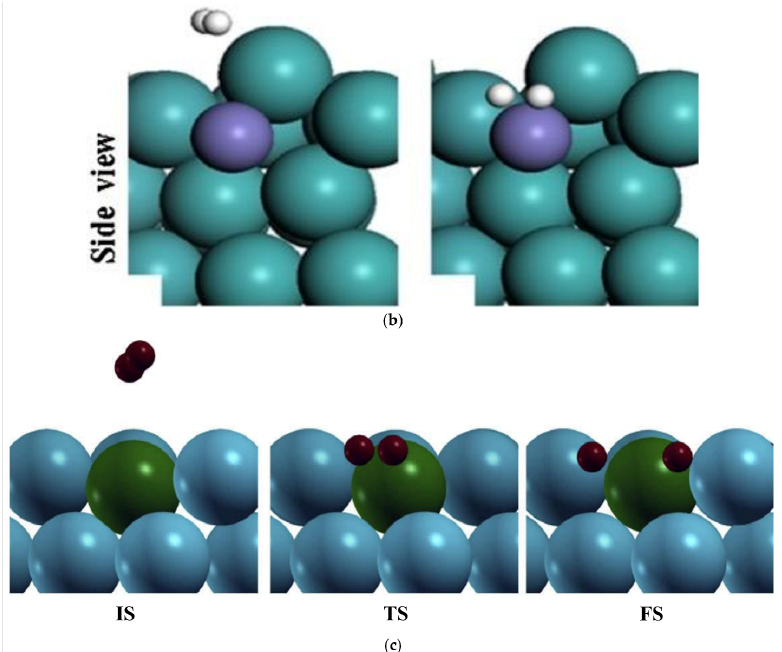
Figure 21. ( a ) Top view of four on-surface adsorption sites on the Mg(0001) surface. Dark blue balls denote Mg atoms, and red balls represent the four different adsorption sites. ( b ) H 2 (gray white balls) dissociation over the Fe-doped Mg(0001) surface when Fe (light blue ball) is in the subsurface (capped by a kicked-out Mg atom) as viewed from the side position. ( a , b ) Reproduced with permission [204]. Copyright 2014, Elsevier. ( c ) H 2 (dark red) dissociation over the Ag-doped Mg surface as viewed from the side position at IS, TS, and FS. The Mg, Ag, and H atoms are represented, respectively, by light grey, dark grey, and black colors. The TM is exposed to the surface, not capped by a kicked-out Mg atom. Reproduced with permission [211]. Copyright 2008,